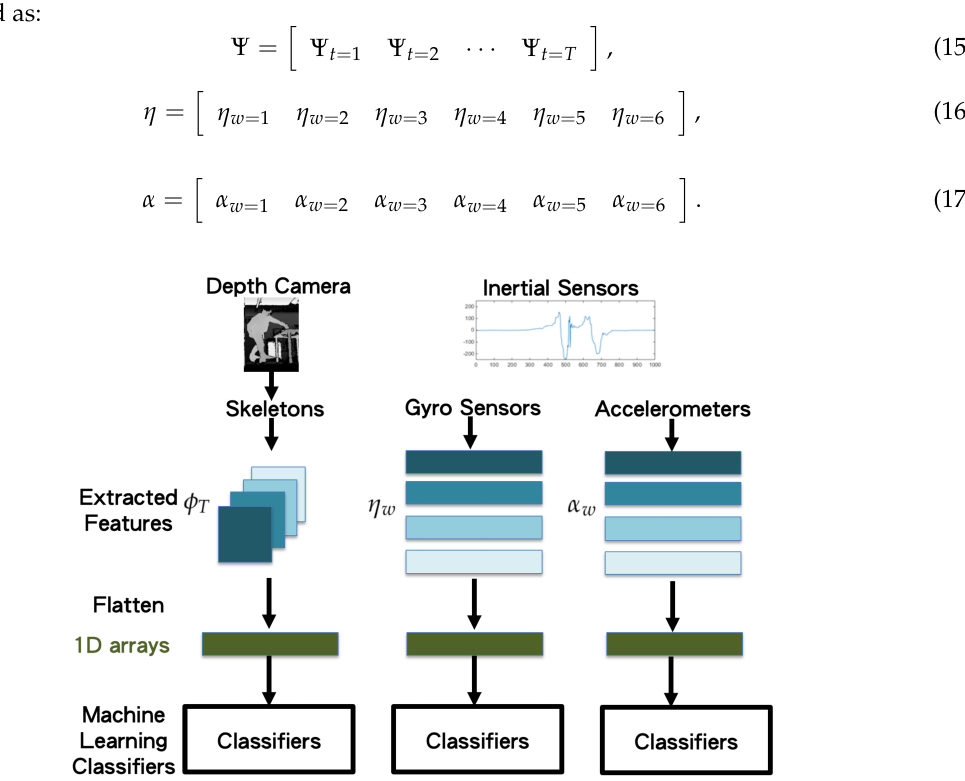
Figure 6. Flattened 1D vectors of the extracted feature